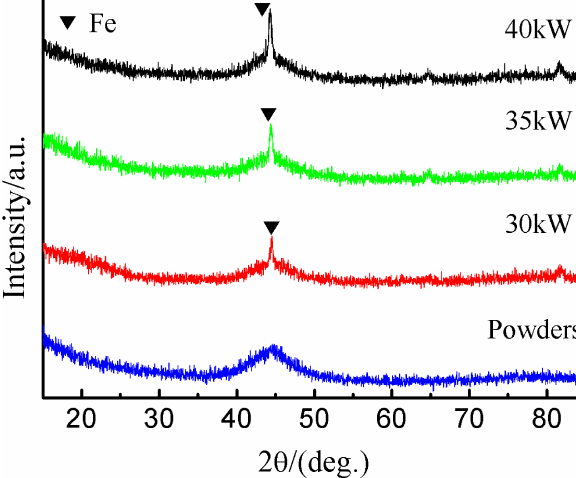
Figure 3: XRD patterns of the powders and coatings deposited under different spraying power